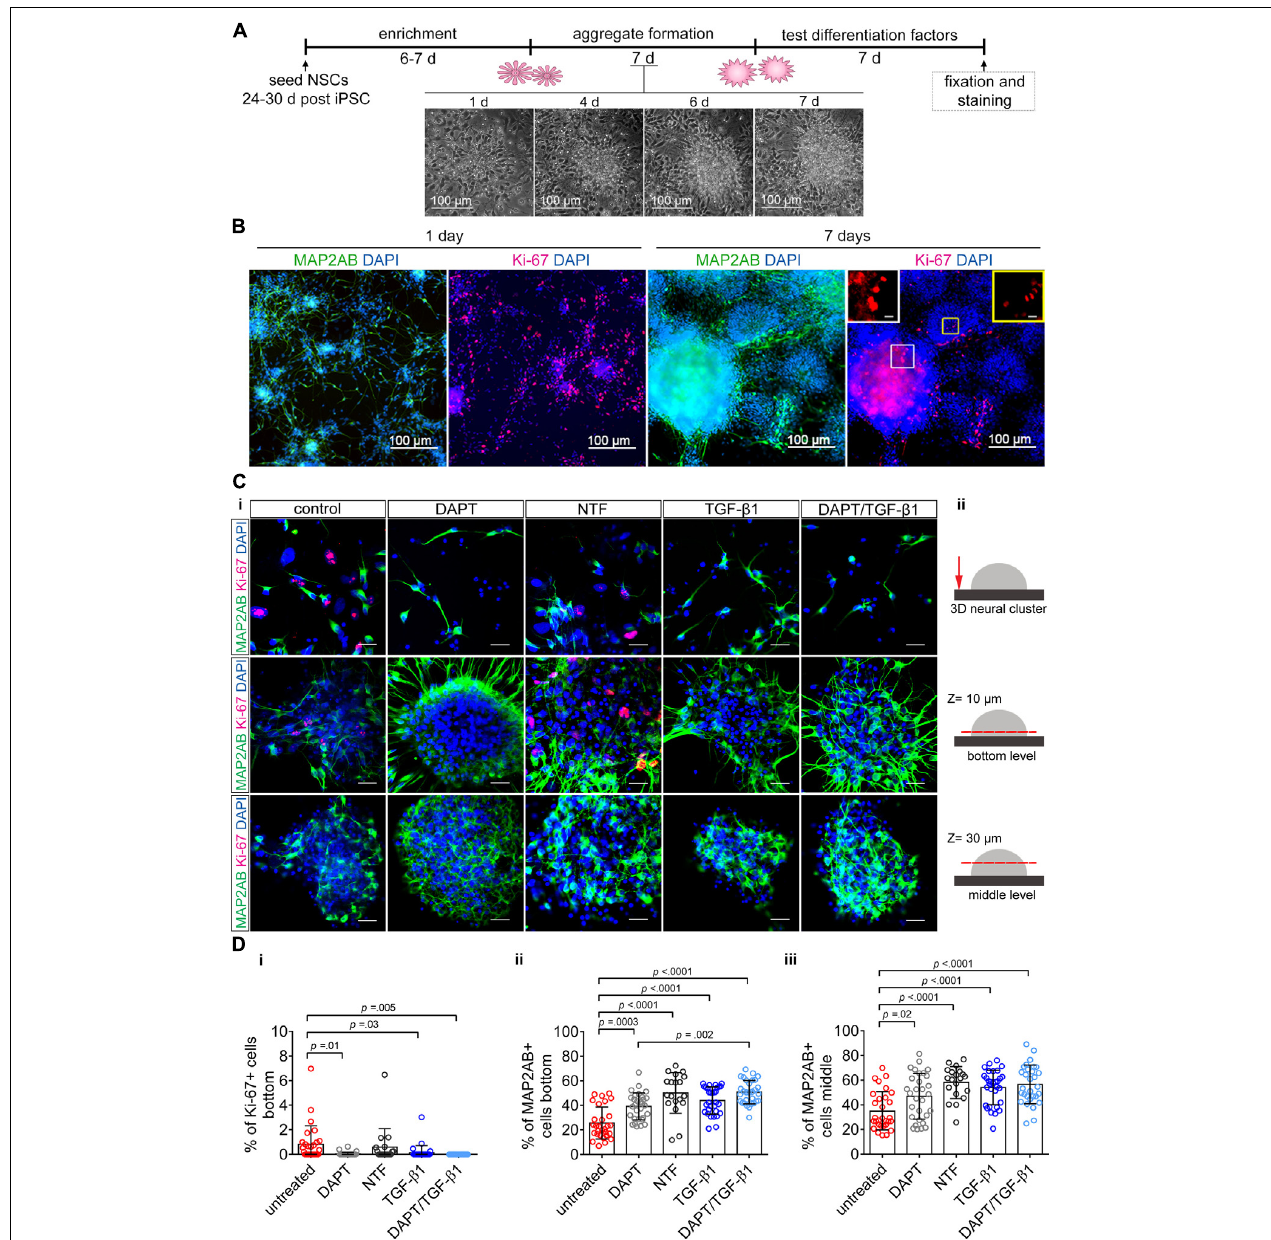
FIGURE 4 | The impact of TGF- β 1 on human iPSC-derived 3D neural aggregates. (A) Schematic representation of the experimental design. Time-lapse imaging shows the transition of neural rosette toward 3D-neural aggregate within 7 days. (B) Confocal images visualize MAP2-AB + -neurons and Ki-67 + -cells in neural rosettes and 3D-neural aggregates (day 30 post iPSC stage). Insets show Ki-67 + -cells at higher magnification. (Ci) Detailed confocal images visualize MAP2AB + -neurons and Ki-67 + -proliferating cells in untreated, DAPT, neurotrophic factor mix (see main text), and TGF- β 1 and DAPT/TGF- β 1 treated hiPSC-NSC cultures. Scale bar: 20 µ m. (Cii) Schematic drawings illustrate the regions and z-levels of image acquisition. (D) Diagrams show the percentage of (i) Ki-67 + -cells and (ii,iii) MAP2AB + -neurons under the indicated culture conditions. Data are shown as mean ± standard deviation, one-way ANOVA with Tukey’s correction (multiple comparisons) was used to calculate the indicated p -values (line ChiPS4, N = 3, each dot represents one aggregate, taken from 2 to 3 technical